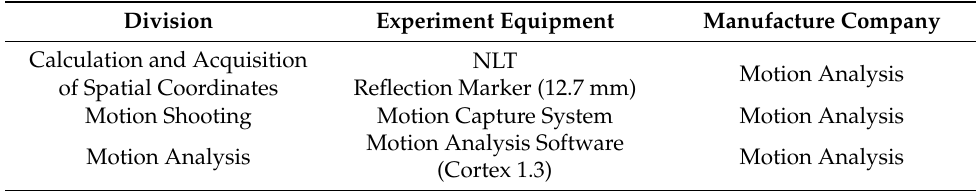
Table 2. Experimental